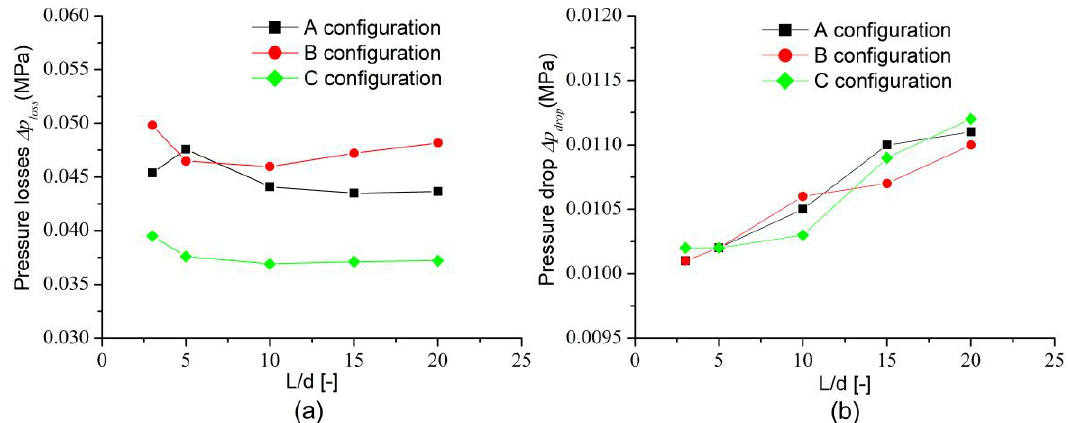
Figure 13. Influence of channels pitch on: ( a ) pressure loss; ( b ) pressure drop.